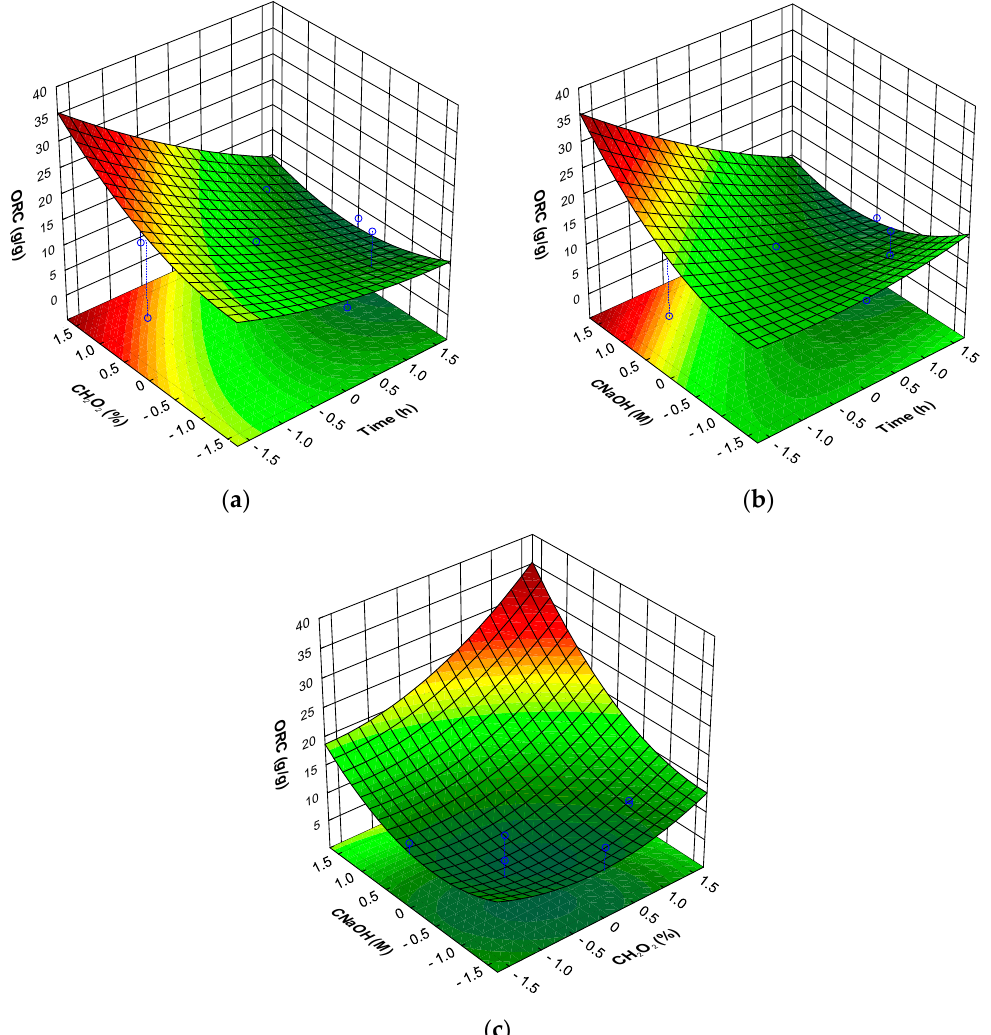
Figure 5. Response surfaces for mushroom DFI oil retention capacity (ORC) as a function of: ( a ) time and hydrogen peroxide concentration (at sodium hydroxide concentration level of 1.682); ( b ) time and sodium hydroxide concentration (at hydrogen peroxide concentration level of 1.682); ( c ) hydrogen peroxide concentration and sodium hydroxide concentration (at time level of − 1.682).